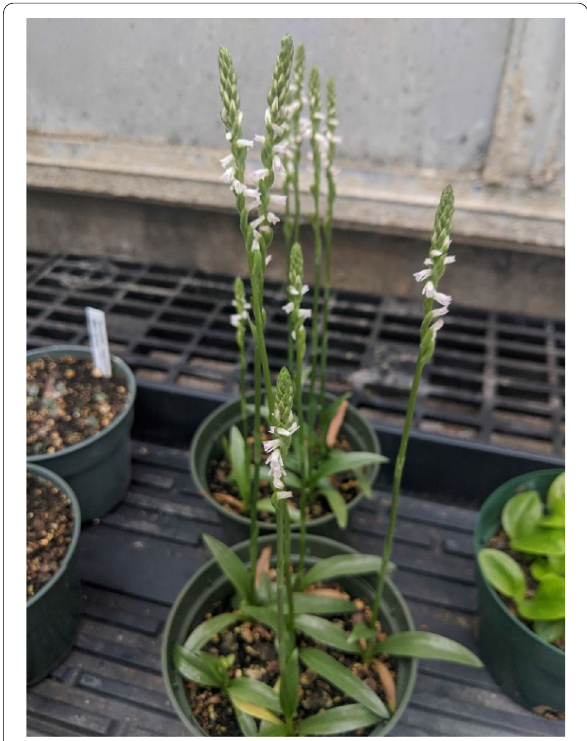
Fig. 4 Spiranthes sinensis cultivated to the blooming stage at the Missouri Botanical Garden (MBOT) after seeds were symbiotically cultured with Tulasnella calospora 266 in vitro following the same protocols for S.